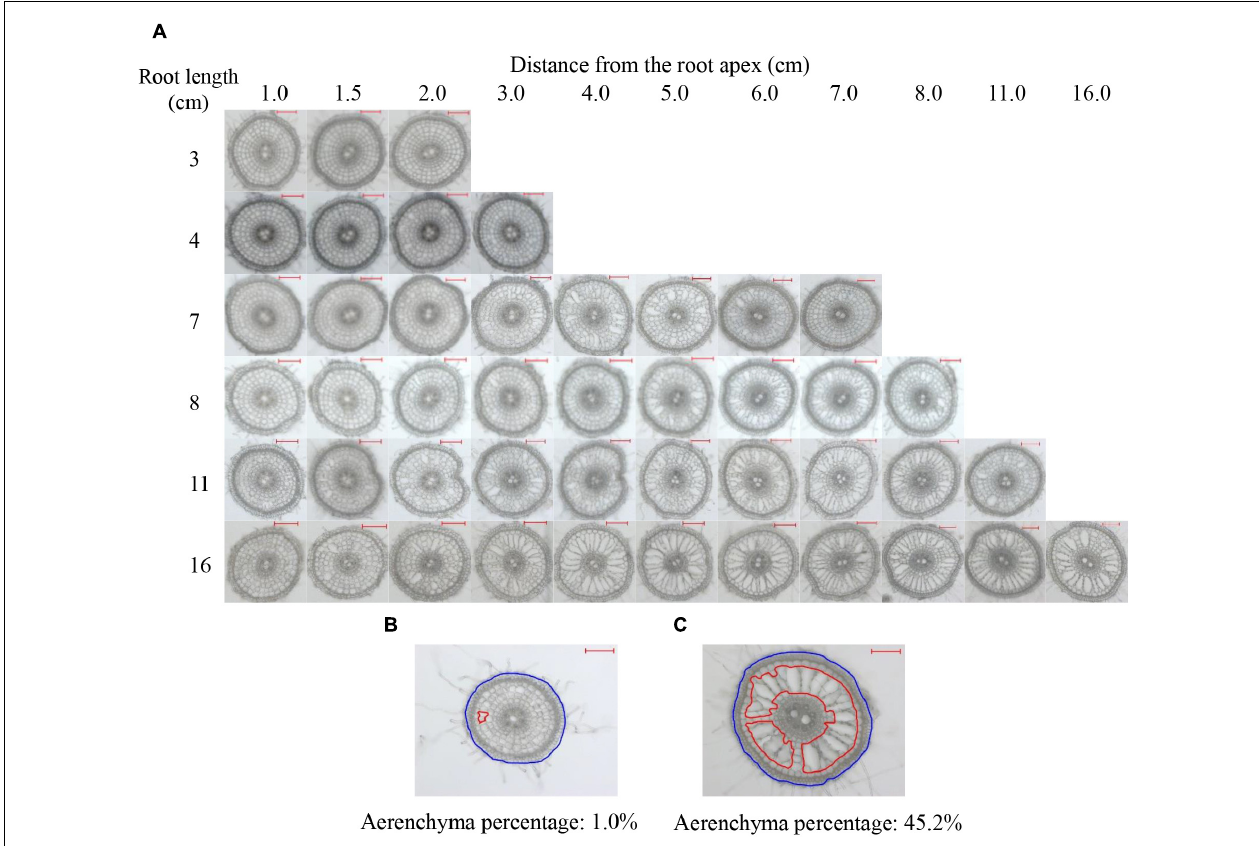
FIGURE 1 | Typical cross-sections of rice adventitious roots with different lengths. (A) Pictures of the cross-sections of adventitious roots with lengths of 3, 4, 7, 8, 11, and 16 cm. (B) The minimum estimation of aerenchyma. (C) The maximum estimation of aerenchyma. The lacunae encircled by red lines denote the aerenchyma area of the root. The region encircled by blue lines denotes the cross-sectional area of the root. All lines were drawn using ImageJ software. Aerenchyma percentage: the percentage of aerenchyma area to the cross-sectional area; Bars = 200 µ m.